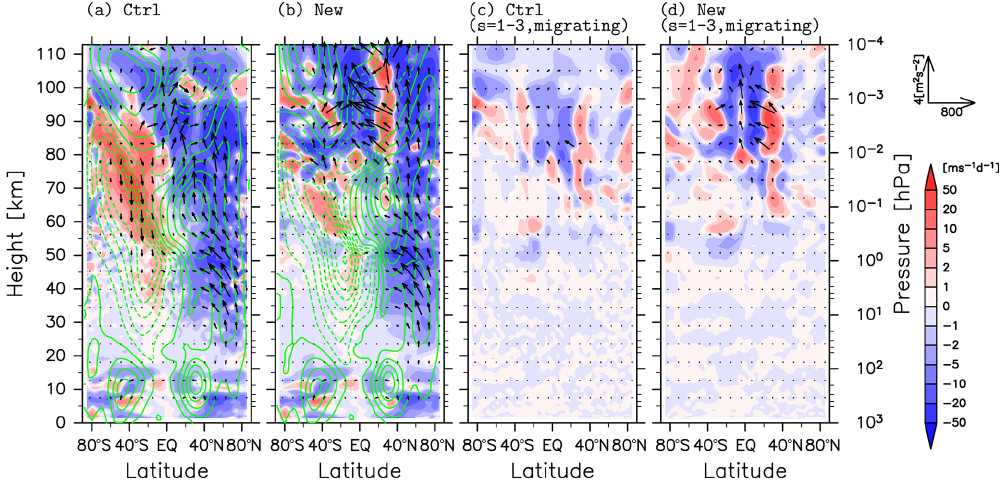
Figure 7. (a, b) The zonal mean zonal wind (green contours), E-P flux (arrows), and E-P flux divergence (colors) averaged for the period of 15 January to 20 February 2017. The E-P flux of panel (a) is the result of all the waves for the Ctrl (KSMW20) analysis and that of ( b ) for the new (Expt. IV) analysis. Contour intervals are 10ms − 1 . (c, d) Same as (a, b) but for the E-P flux and E-P flux divergence for the migrating large-scale (wavenumber s < 4)